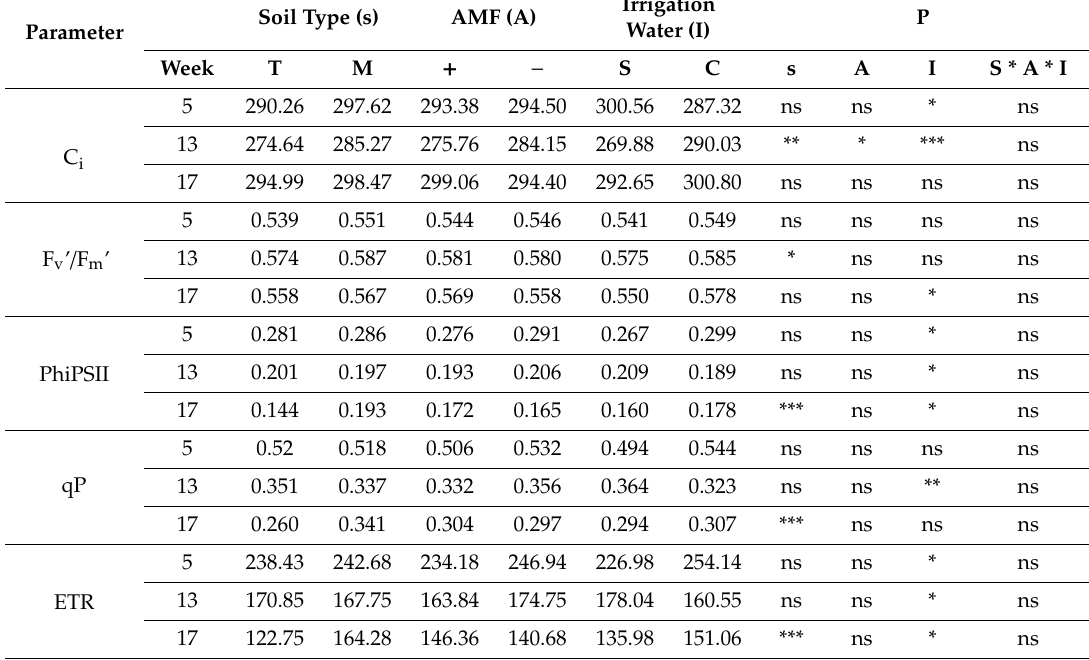
Table 4. Fluorescence parameters (Ci: Internal CO2 concentration; F v ’ / F m ’: The excitation capture e ffi ciencyofopencentres; PhiPSII:PSIIe ff ectivequantumyield; qP:Photochemicalquenchingcoe ffi cient; and ETR: Apparent electron transport rate), depending on soil type (s) (traditional: T and mixed: M), AMF inoculation (A) (with: + or without: − ), irrigation water (I) (saline: S, control: C), and interaction among them, at weeks 5, 13 and 17. Statistical significance according to one-way and three-way ANOVA tests. Values are means of six samples.